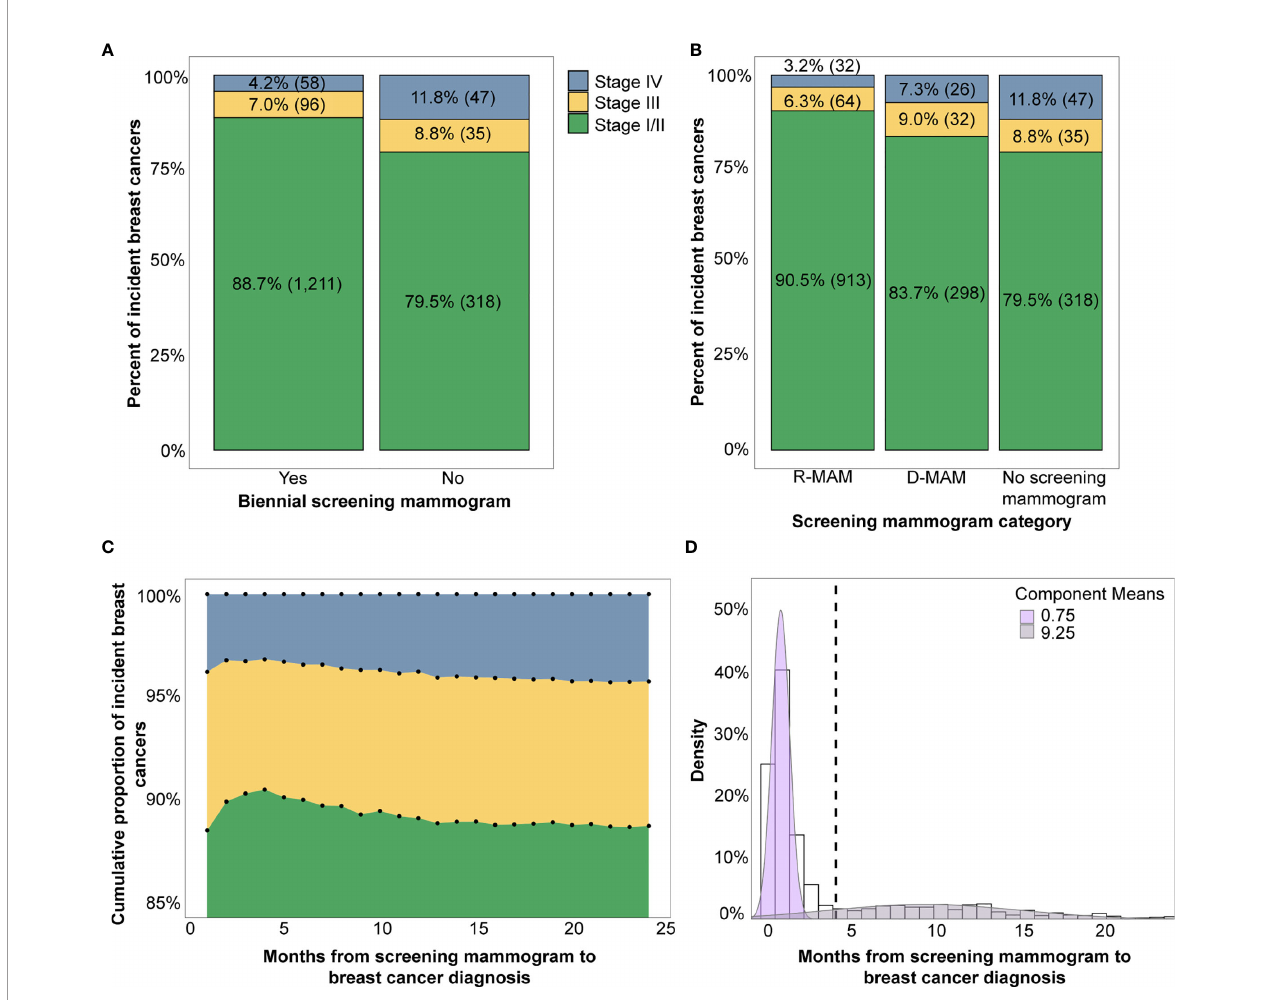
FIGURE 2 | (A) Breast cancer stage distribution by presence of a biennial screening mammogram (yes vs. no) and (B) Breast cancer stage distribution by time from screening mammogram grouped into R-MAM (screening mammogram <4 months from diagnosis) and D-MAM (screening mammogram 4-24 months from cancer diagnosis). (C) The cumulative proportion of each stage of incident breast cancers by months from the screening mammogram to breast cancer diagnosis. (D) Distribution of months from screening mammogram to breast cancer diagnosis is bimodally distributed and modeled by a two-component Gaussian mixture. Note that percentages may not add to 100% due to